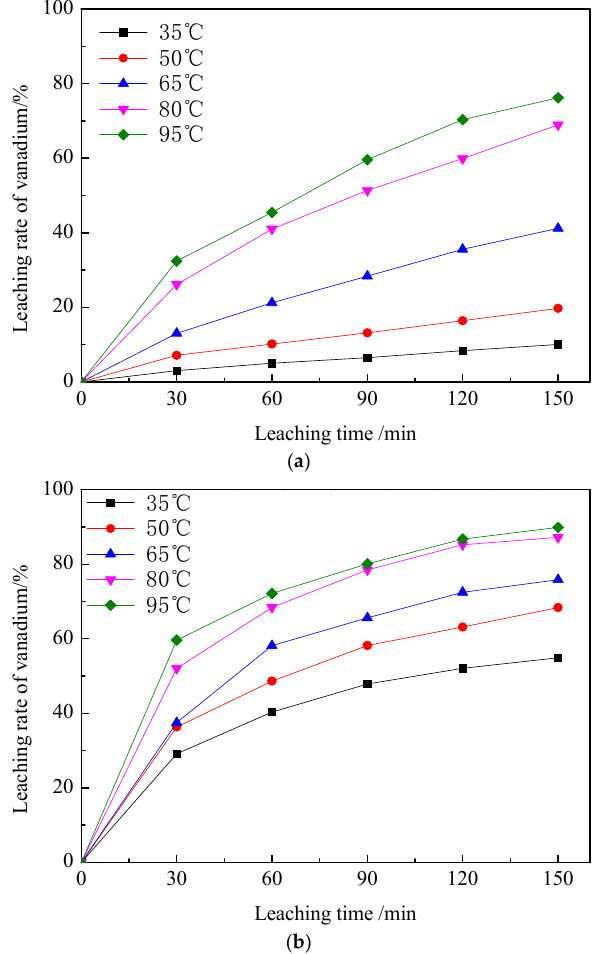
Figure 10. The relationship between the leaching rate and leaching time of vanadium at different leaching temperatures. ( a ) Blank roasting clinker; ( b ) Calcified roasting